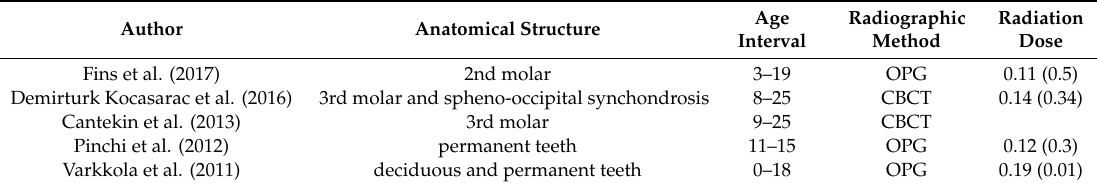
Table 5. Summary of data regarding the accuracy of dental methods for age estimation.